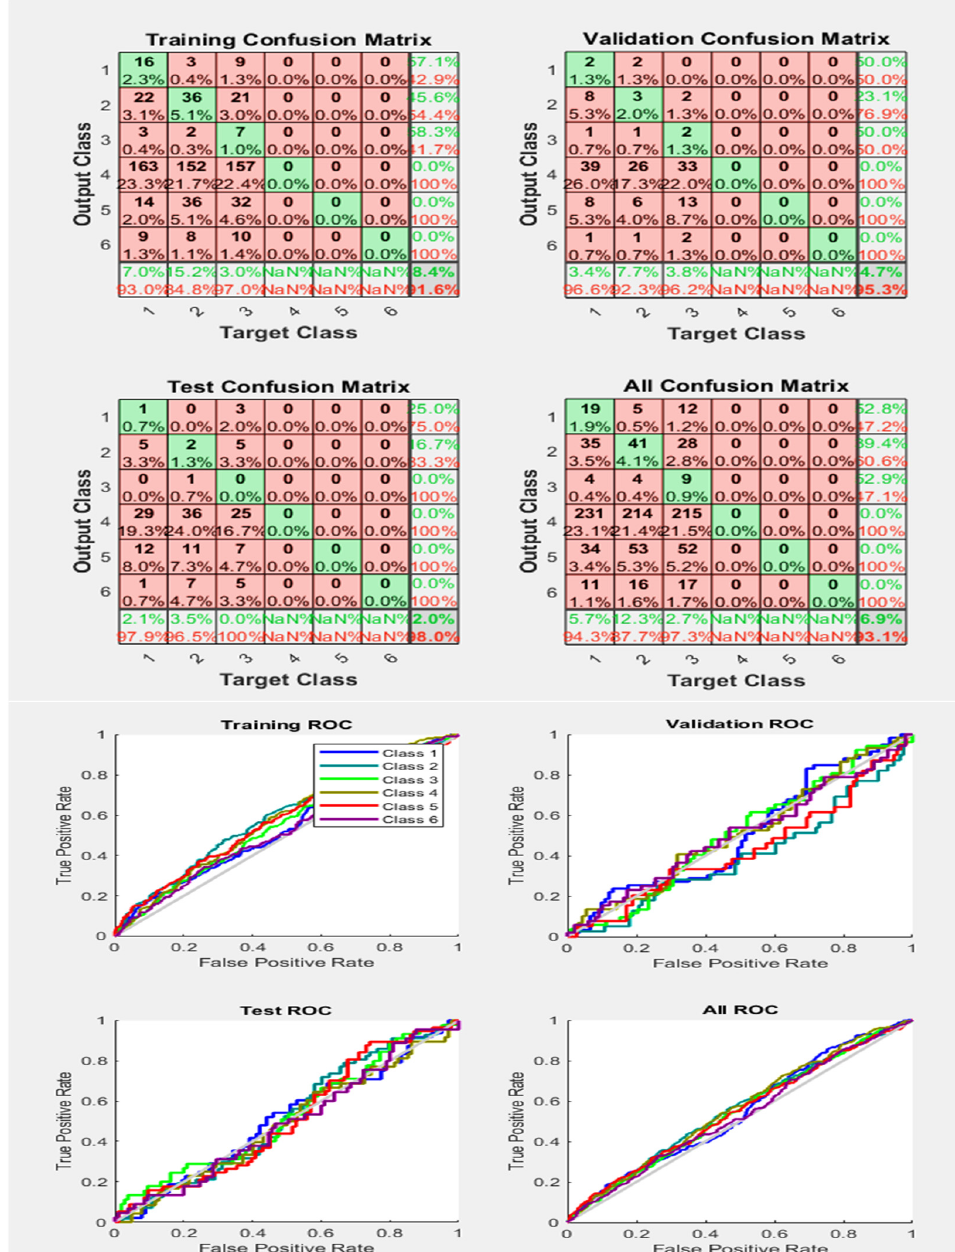
Figure 18. Neural Network Model ROC (Receiver Operating Characteristics) and Confusion Matrix for LM TrainFcn/Activation Function at level 9 (RMS) Features for High Contact Resistance Fault with 93.1% Accuracy. Grey line shows diagonal of the ROC for indicating Class 1–6 lines are lying above or below or on it.